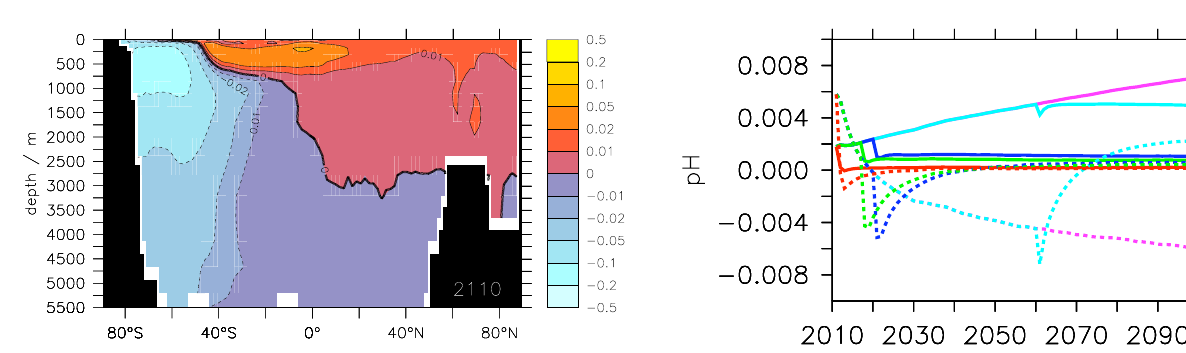
Fig. 9. Simulated evolution of OIF-induced changes in surface pH (averaged over 0–125m depth). Dashed lines refer to pH changes averaged over the fertilized area south of 30 ◦ S, solid lines refer to the globally averaged pH changes.